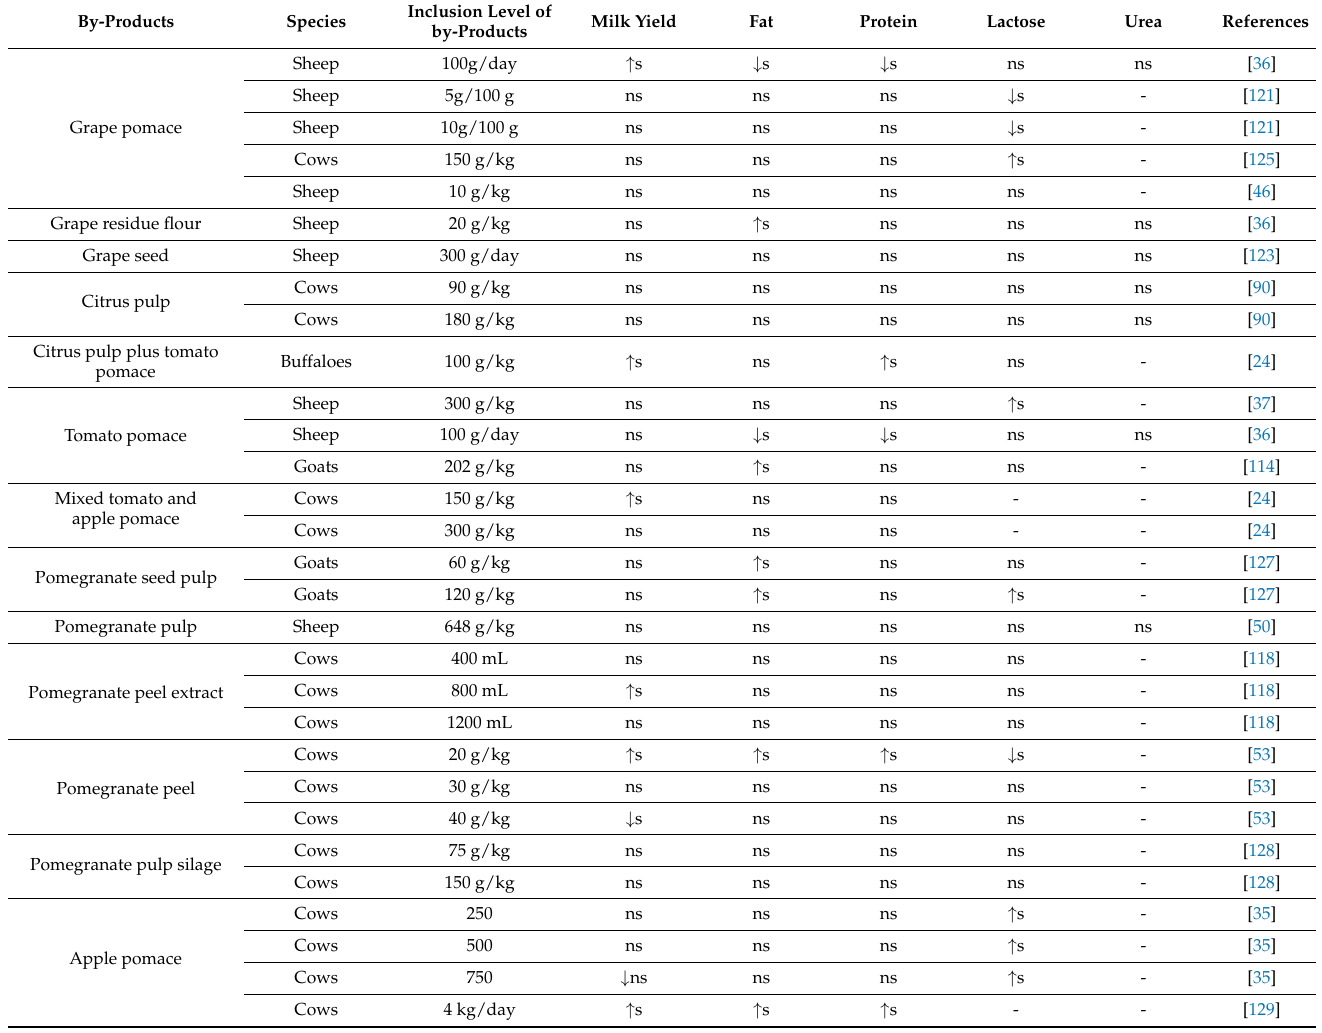
Table 5. Effects of FVBPs on milk production and composition in